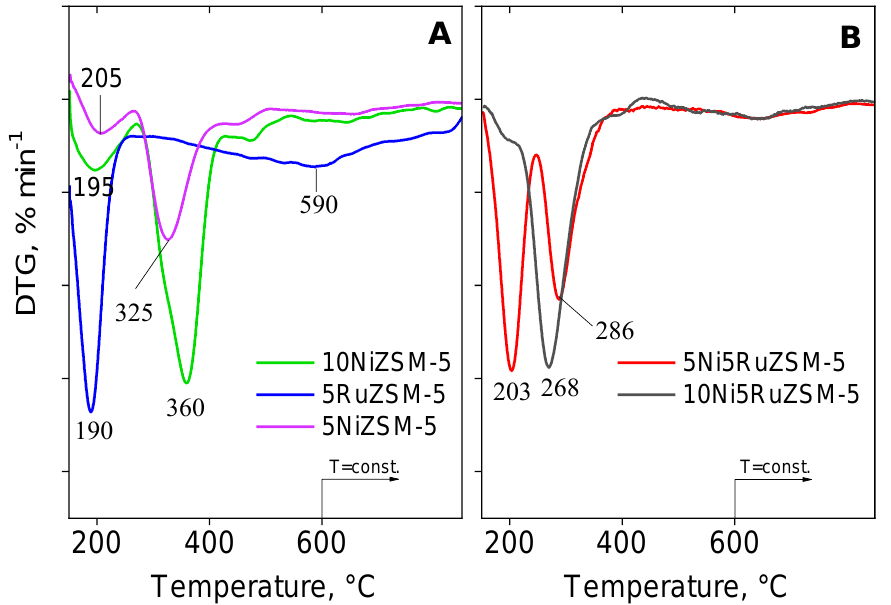
Figure 3. TPR-DTG profiles of the Ni- and Ru-modified monometallic ( A ) and bimetallic ( B ) ZSM-5 zeolites.